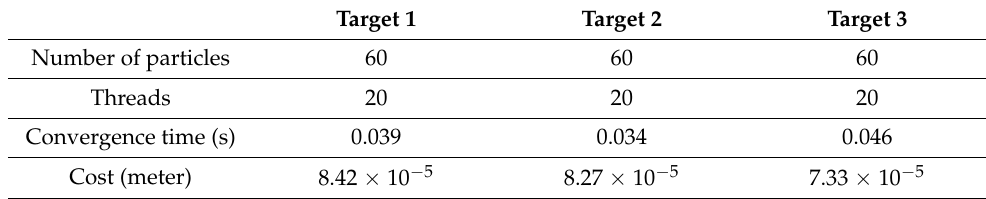
Table 4. Three particles per